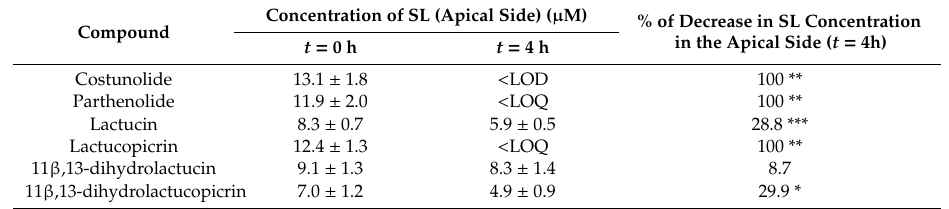
Table 3. Concentration of SLs in the apical compartment before and after the permeability experiment. Table 4. Comparison between SLs and their respective cysteine conjugates, in terms of retention time, m / z and peak areas. Parent SLs were added at 10 µ M in the apical side at t = 0h.